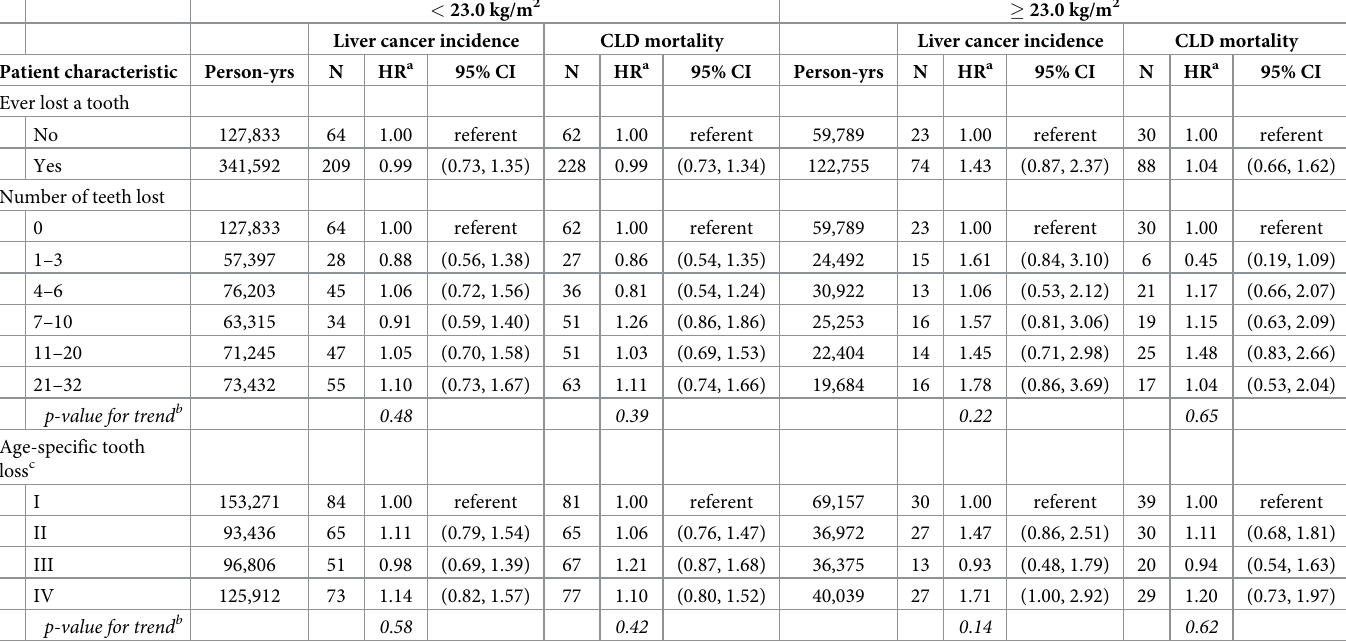
Table 4. Association of tooth loss to incident liver cancer and chronic liver disease (CLD) mortality by body mass index in the Nutrition Interventions Cohort, Lin- xian, China,